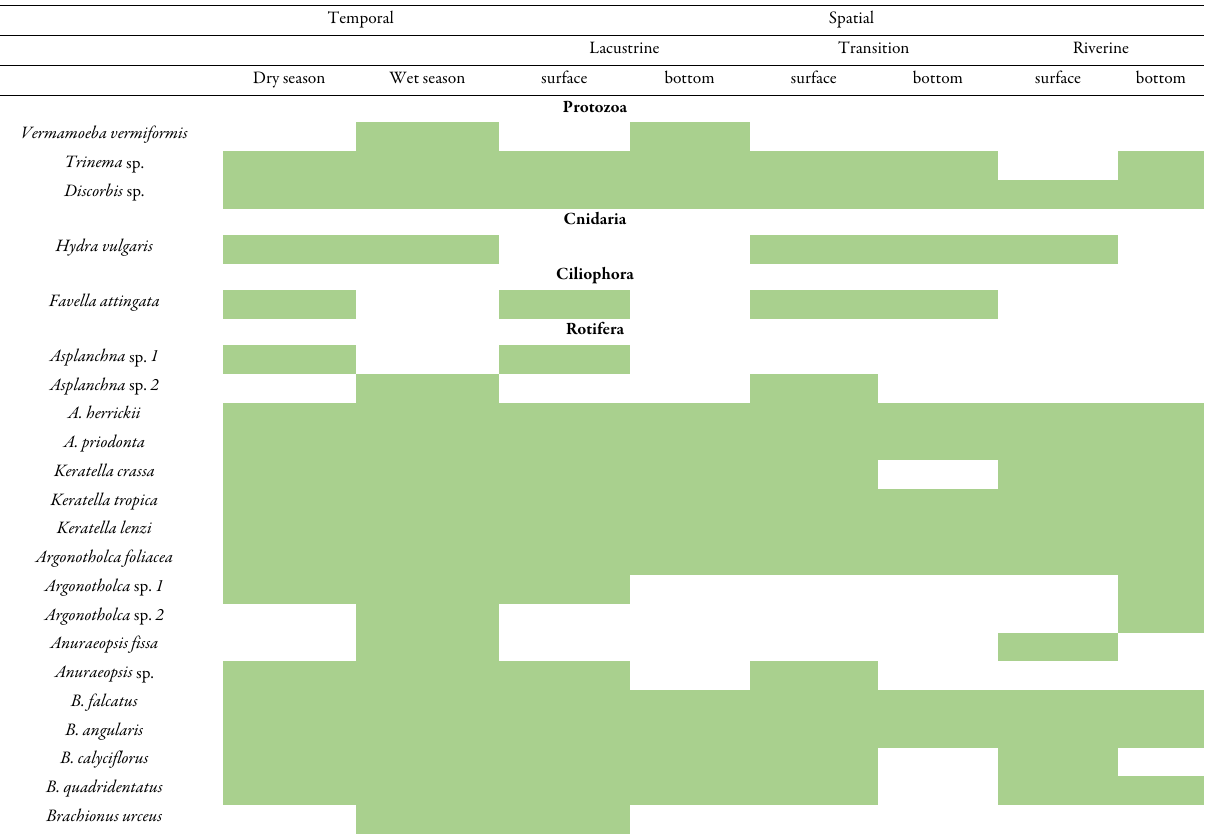
Table 3. Spatial and temporal occurrence of zooplankton and related